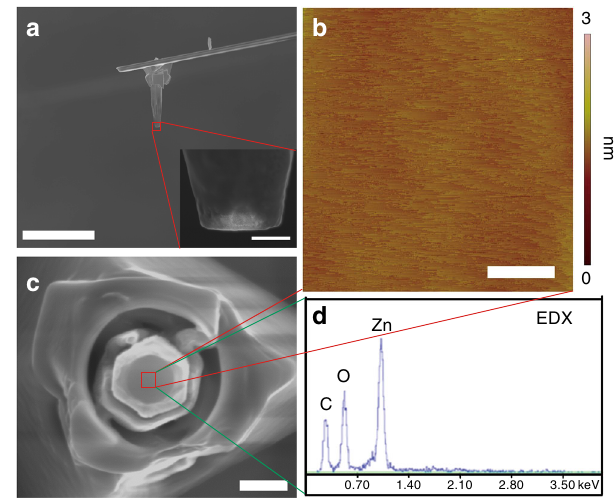
Fig. 1 SEM and AFM images of a ZnO(0001) AFM tip. a Side view ( scale bar 10 µ m), the inset ( scale bar 100 nm) is a high magni fi cation image to show surface fl atness; b Top view ( scale bar 500 nm); c an AFM image of the ZnO tip surface, collected by reverse imaging using a whisker substrate ( scale bar 25 nm); and d an EDX spectrum of the ZnO tip